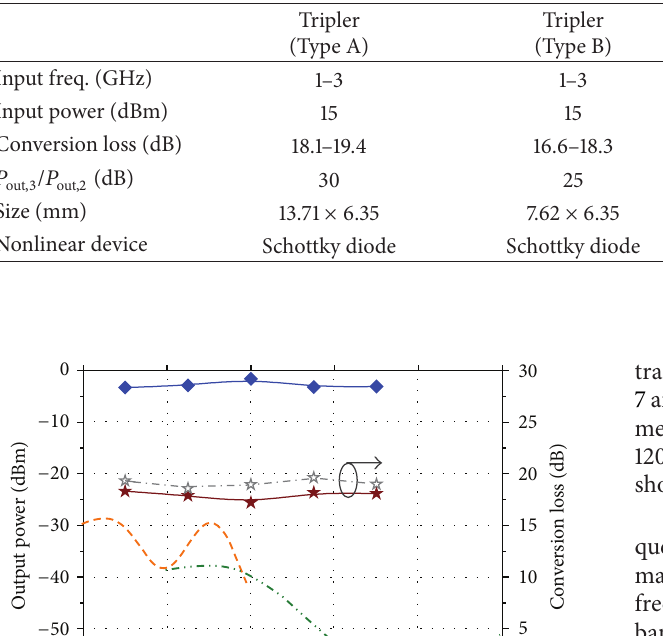
Table 2: Performance comparison of the frequency triplers.